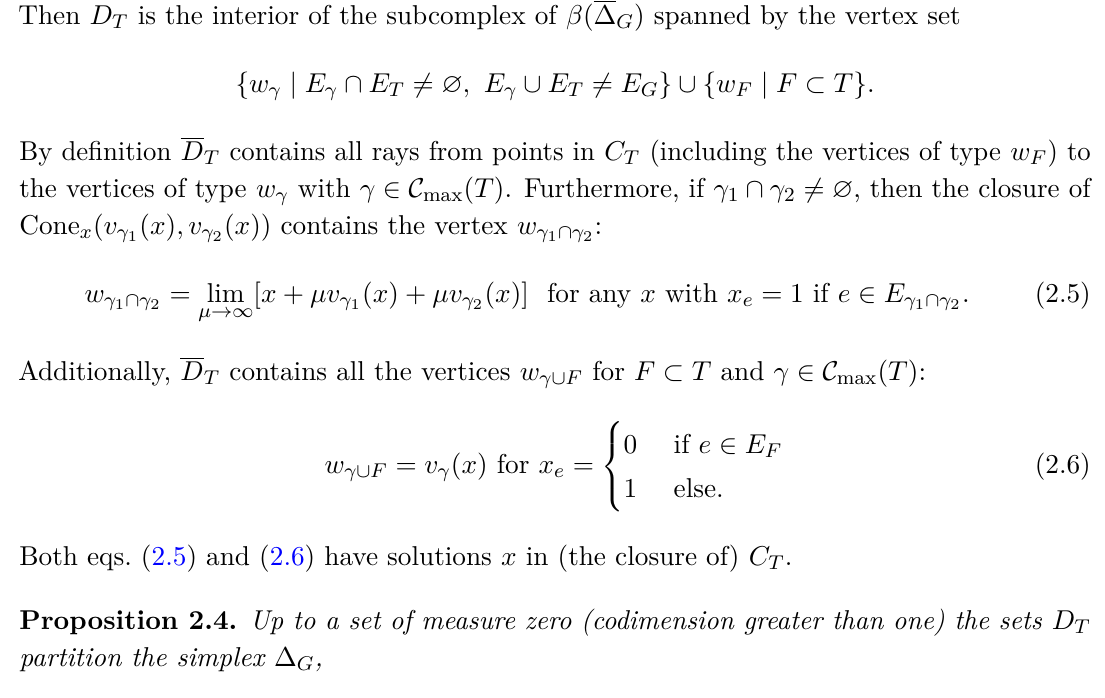
Figure 3 . Cubes C T (red) and sectors D T (blue) for T = { e 2 , e 3 } and { e 2 , e 4 } . The orange vertex marks the center of ∆ . The two blue points are the vertices of β (∆ G two core subgraphs on edges e and e , 3 , e 4 1 , e 2